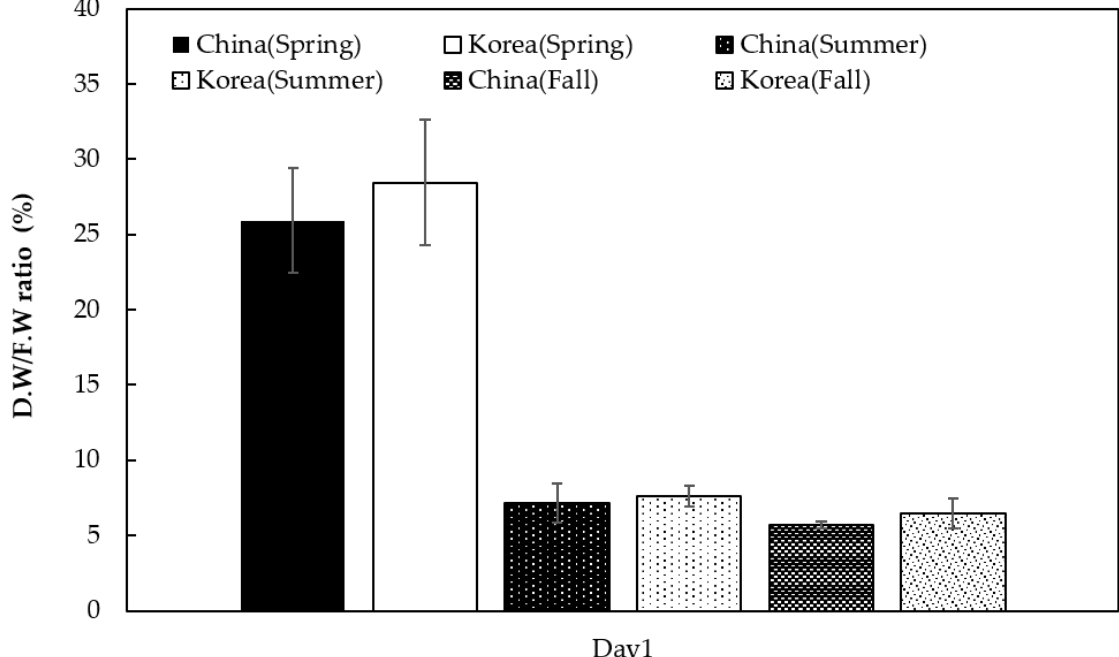
Figure 3. Changes of ratio of dry and fresh weight of cut Phalaenopsis “V3” flowers based on the place of origin and season.